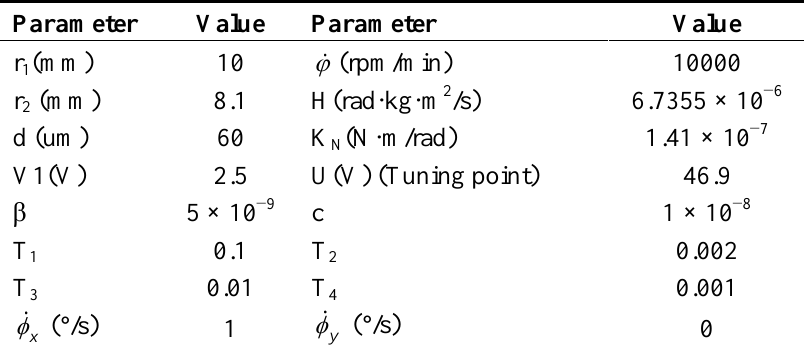
Table 3. The simulation parameters.